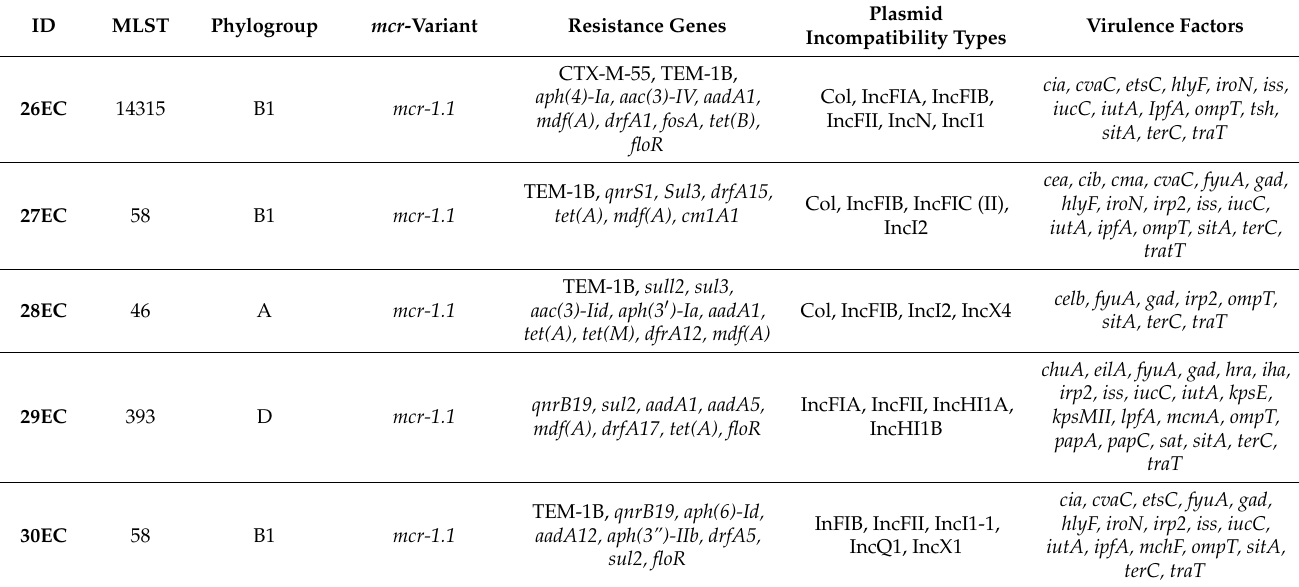
Table 2. Genomic characteristics the mcr-1.1 -harboring E. coli